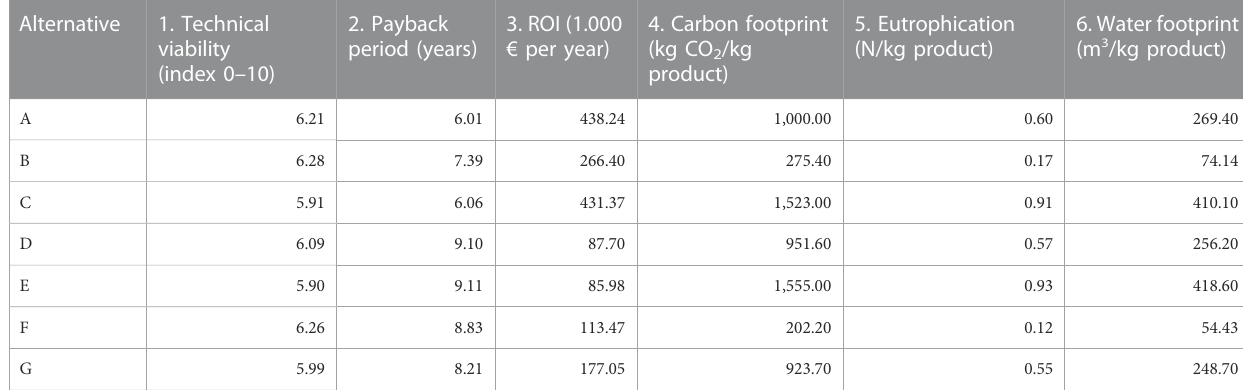
TABLE 1 Decision makers ’ input values for each alternative that is being evaluated based on the six criteria.